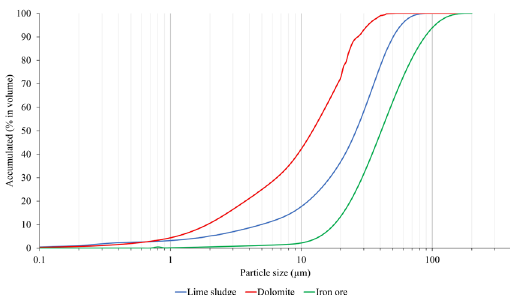
Figure 1. Size analysis of lime sludge, dolomite, and iron ore used to produce iron-ore